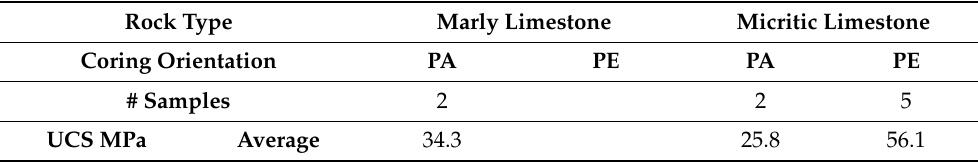
Figure 8. The crack initiation (CI) threshold values were calculated after several techniques detailed in Table 3. Legend stands for different calculation methods from Brace et al. [47], Latjai [48], Stacey [49], Diederichs [50], and Ghazvinian [51]. The marly and micritic limestone results are shown separately, distinguishing between PA and PE for the micritic limestone. No samples of PE for marly limestone could be used to calculate the CI threshold. PA: parallel; PE perpendicular. Table 7. Summary of Uniaxial Compressive Strength (UCS), crack closure stress (CC) and crack initiation stress (CI) levels, for marly and micritic limestone from Member I, Thebes Limestone Formation. Brackets indicate the thresholds in ratio of stress to UCS. Samples with silica bands were excluded here and average UCS of the remaining tests are given. # stands for